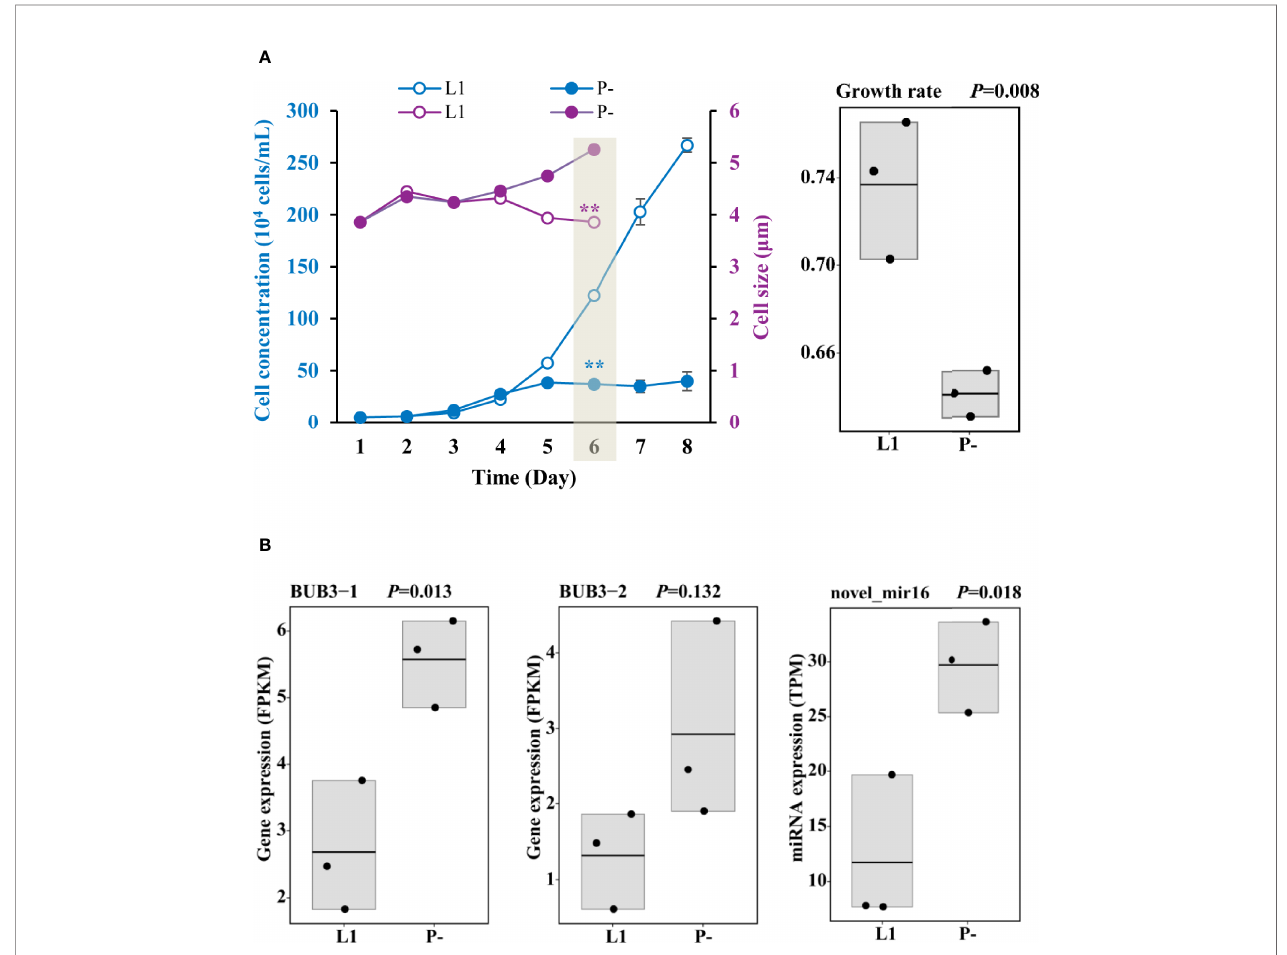
FIGURE 1 | Responses of growth and cell size to P-limitation (P-) compared to P-replete condition (L1) and the corresponding gene expression. (A) Depressed growth, enlarged cell size, and inhibited growth rate on Day 6 in P- treatment relative to L1. Shading indicates when samples for RNA and miRNA sequencing were collected. Asterisks indicating signi fi cant differences between P- and L1 cultures, with blue color for cell concentration and purple color for cell size. ** indicates p < 0.001 in t -test. Error bars denote ± s.d. of the mean (n = 3). (B) Up-regulation of cell cycle arrest protein (BUB3) genes and miRNA (novel_mir16) predicted to negatively regulate cell growth. FPKM is the fragments per kilobase million and used for RNA